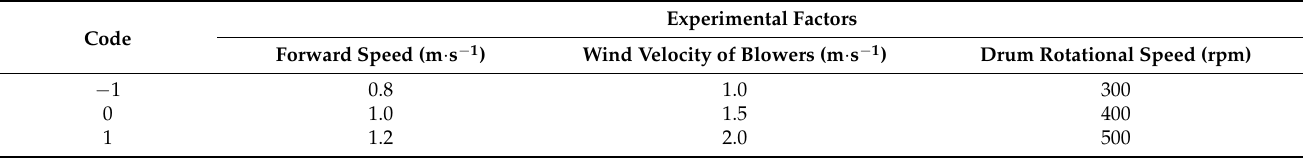
Table 3. Coding of simulation test factors.